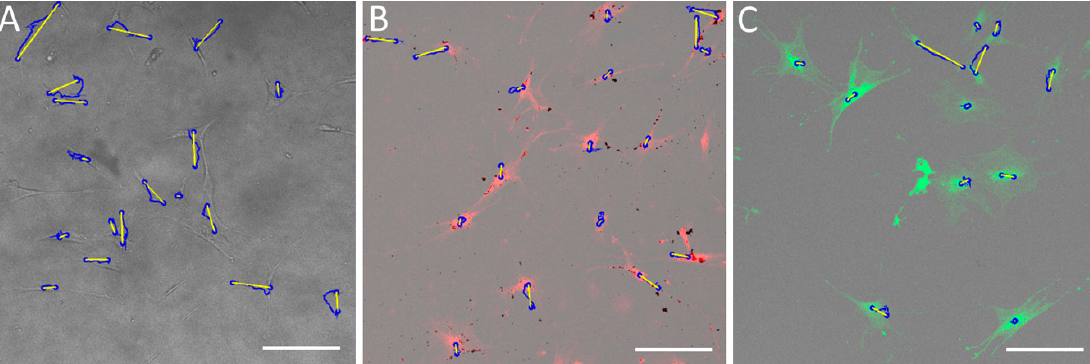
Figure 9. Tracks of hMSCs. ( A ) Non-labelled cells (control); ( B ) SAMN-R treated cells; ( C ) CMFDA- labelled cells. The blue circle is a detected cell, the blue line is accumulated distance, and the yellow line is Euclidean distance. Confocal microscopy, 10× magnification, scale bar 250 µm.